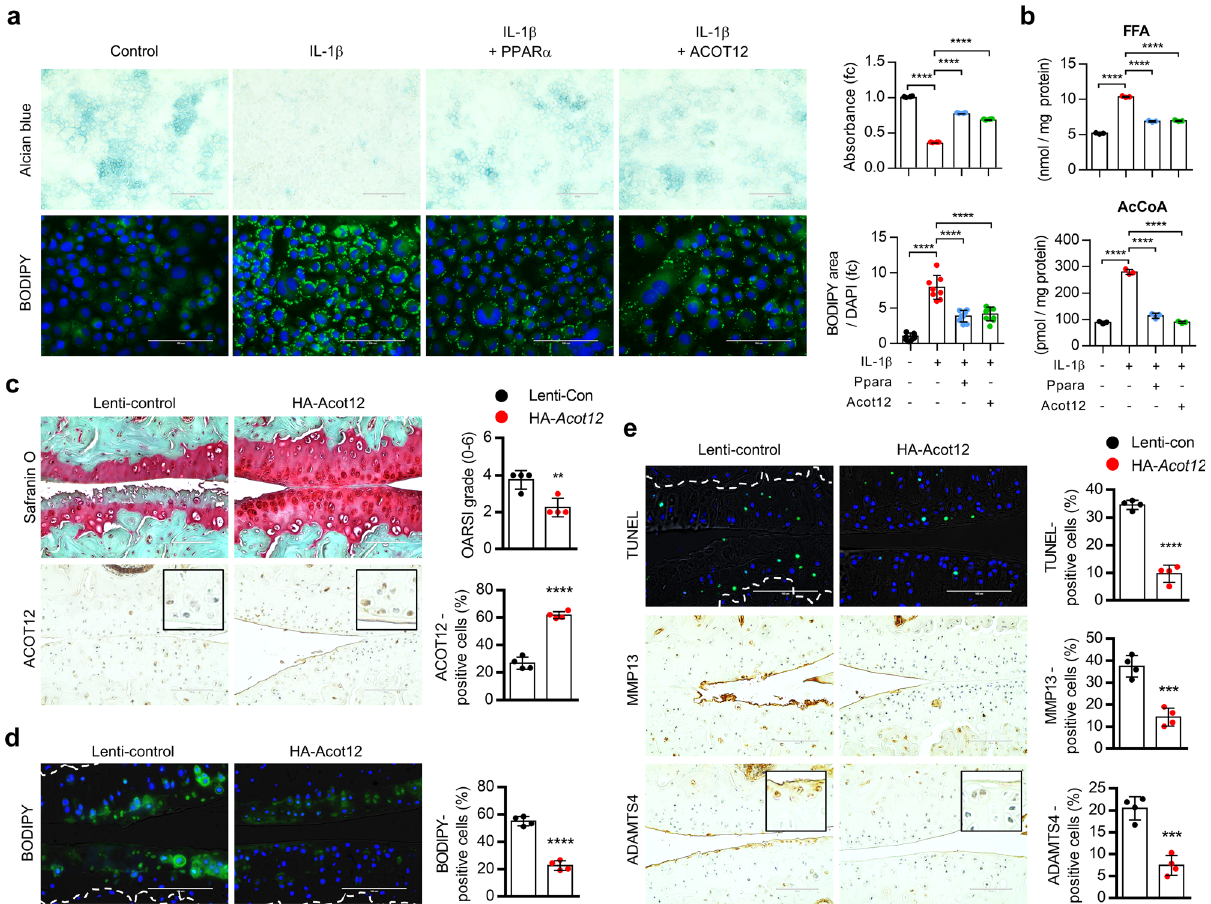
Fig. 7 ACOT12 overexpression alleviates lipid accumulation and OA pathogenesis induced by PPAR α de fi ciency. a Alcian blue ( n = 3) and BODIPY ( n = 8) staining of Ppara − / − iMACs introduced by PPAR α or ACOT12 expression vector in the absence or presence of IL-1 β , P < 0.0001 for Alcian blue, P < 0.0001 for BODIPY. Scale bars, 100 μ m. b Cellular level of FFA ( P < 0.0001) and acetyl-CoA ( P < 0.0001) in Ppara − / − iMACs introduced by PPAR α